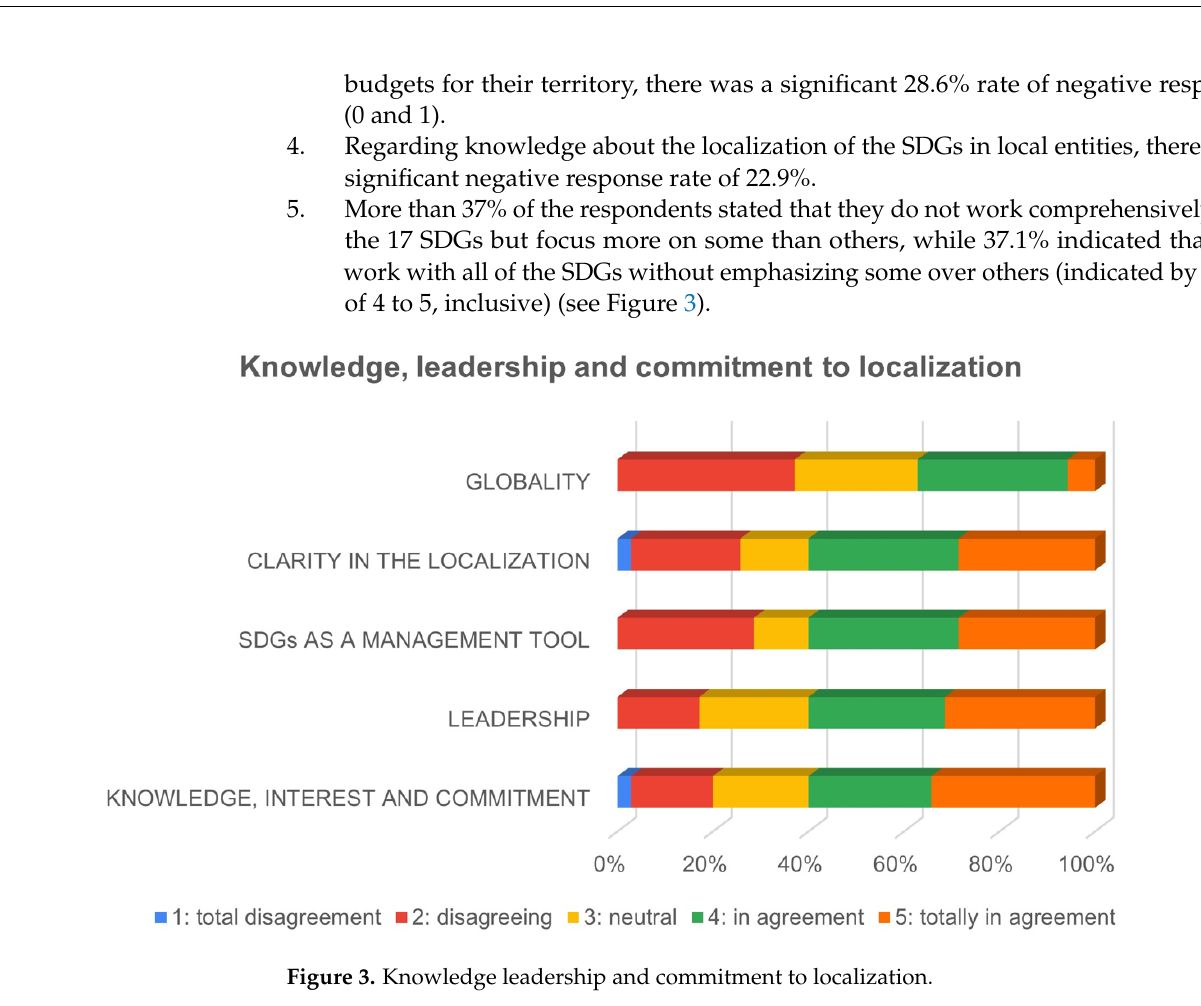
Figure 3. Knowledge leadership and commitment to localization.